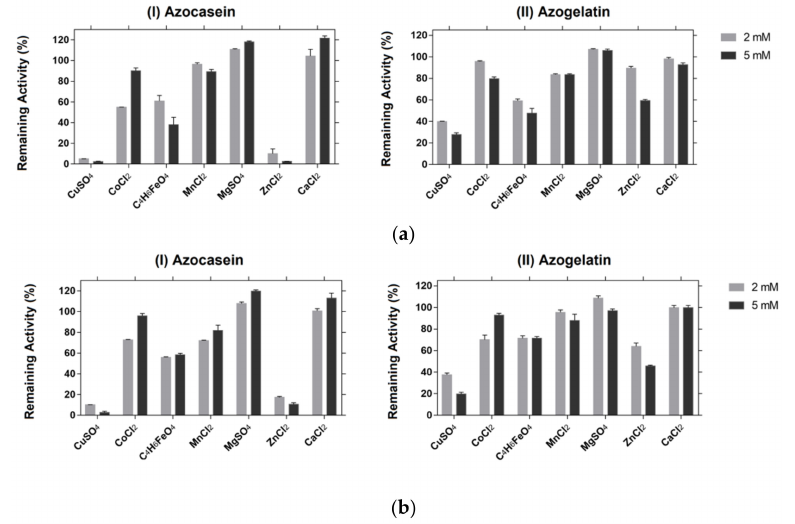
Figure 3. Effect of metal ions on the proteolytic activity. Remaining activity (%) of A. platensis lysate after determination of enzyme activity with (I) azocasein and (II) azogelatin as substrates at ( a ) pH 6.5 and ( b ) pH 9.0, with 2 mM and 5 mM final concentration of metal ions. Proteolytic activity in absence of metals is defined as 100%. The data represent the mean ± SD (N =